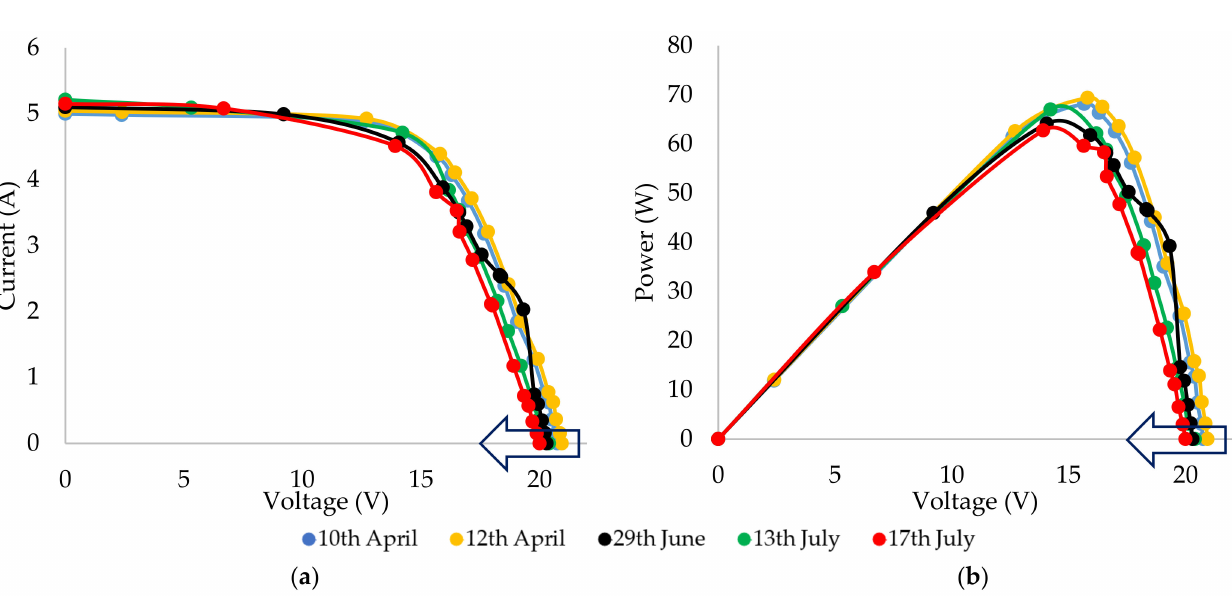
Figure 7. I-V and P-V curves for PV panel P1. ( a ) Temperature effect on PV panel P1 and the I-V curves behavior at 900 W/m 2 with different ambient temperatures, ( b ) Temperature effect on P1and the P-V curves behavior at 900 W/m 2 with different ambient temperatures (see Table